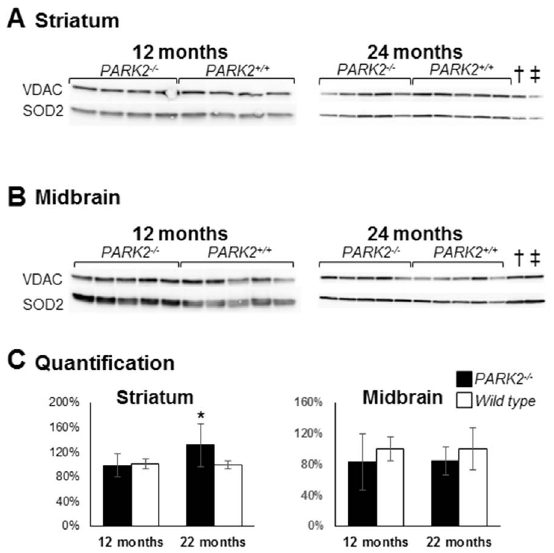
Figure 7. Increased mitochondrial Mn superoxide dismutase (SOD2) in the striatum of PARK2 2 / 2 mice. Western blot analysis of proteins from crude mitochondrial pellets from striatum (A) and midbrain (B) of PARK2 2 / 2 and wild-type mice, at 12 and 24 months of age; loading control was the outer membrane protein Voltage- Dependent Anion Channel (VDAC); (C) densitometric analysis of the SOD2 signal shown in A and B was normalized to VDAC signal and quantification was expressed as means and SD and as % of the mean of wild-type samples on the membrane shown in A and B; *=p , 0.05 using Mann and Whitney test; { and ` : samples from 12-month-old PARK2 2 / 2 and wild type mice respectively showing that the SOD2 steady-state level does not significantly change with age.